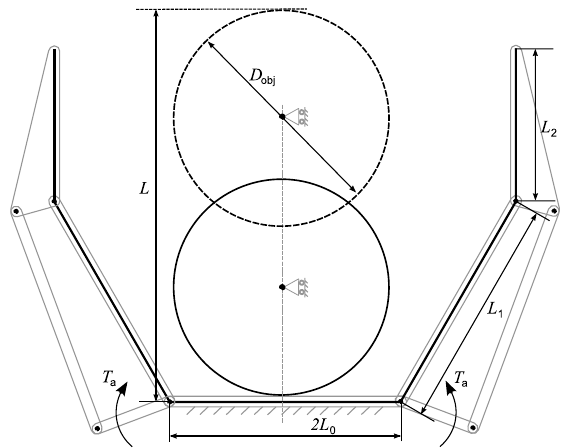
Figure 1. Initial positions of a freely moving cylindrical object with respect to the palm of a hand to determine the ability to successfully grasp this object. The palm position is represented by the solid object, and the pinch position by the dashed object. Dobj is the diameter of the object, 2L0 is the width of the palm, L1 is the length of the proximal phalanx, L2 is the length of the distal phalanx, L is the length of the finger. A torque Ta applies to the base of the fingers.